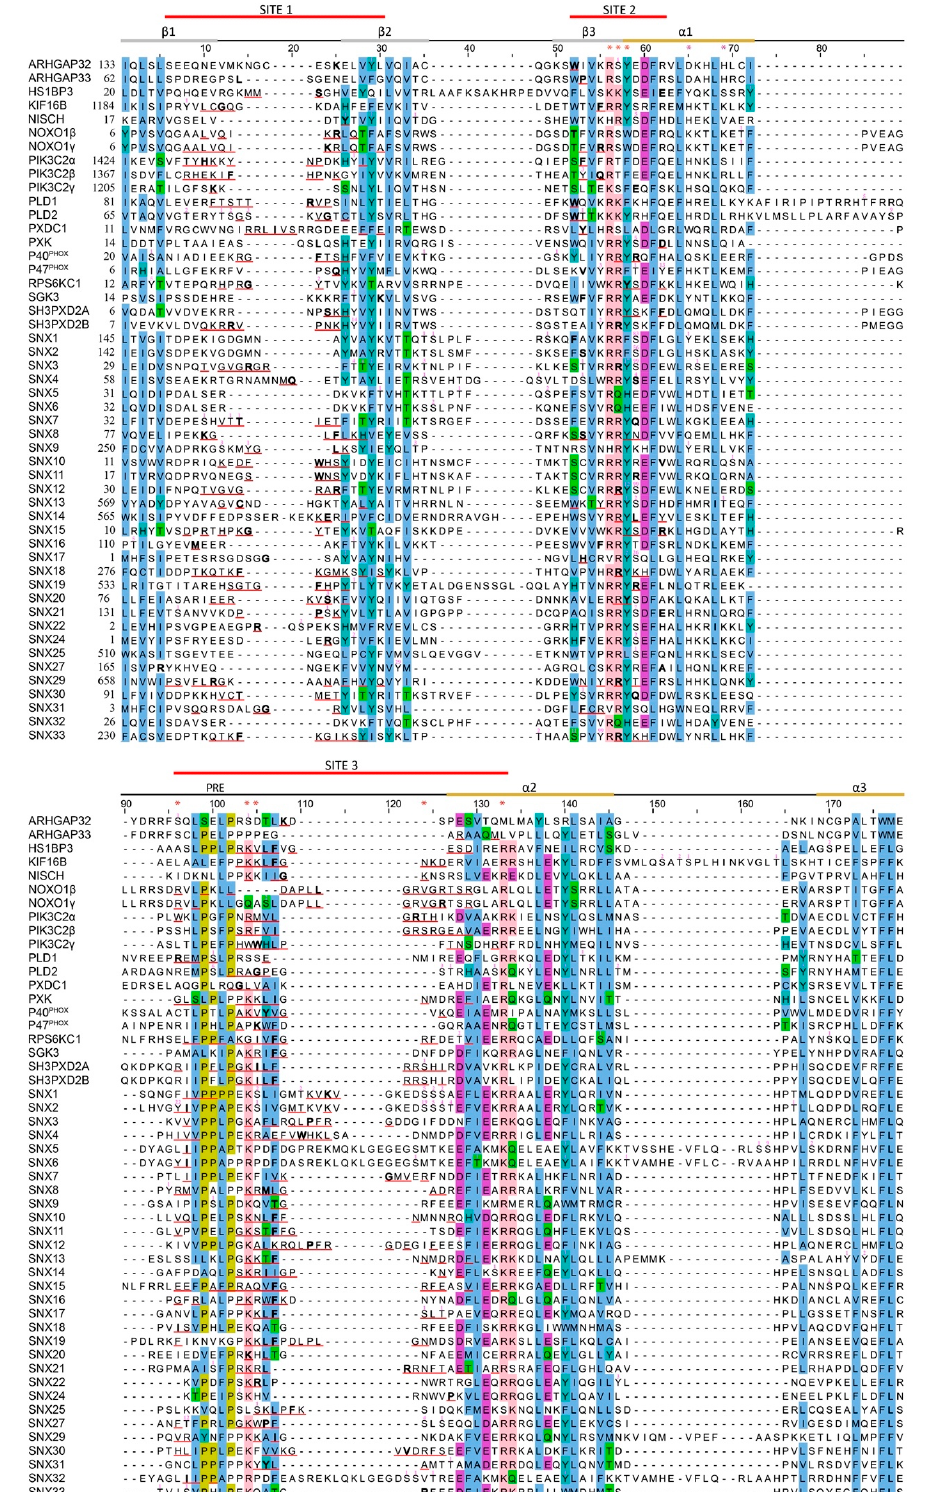
Figure 4. Alignment of the sequences of human PX domains. Phosphorylation sites are annotated with a superscript indicating the number of citations (capped at 99). The 3 membrane binding Sites are indicated with red lines, as are the residues in each Site with MODA scores exceeding 30, and the residue with the highest MODA score in each Site is bolded. Conserved residues are highlighted blue (hydrophobic), olive (Pro), green (polar), acidic (purple), and pink (basic). The secondary structure and PRE are labelled above the sequences. PIP and phosphatidic acid binding residues are asterisked in red and